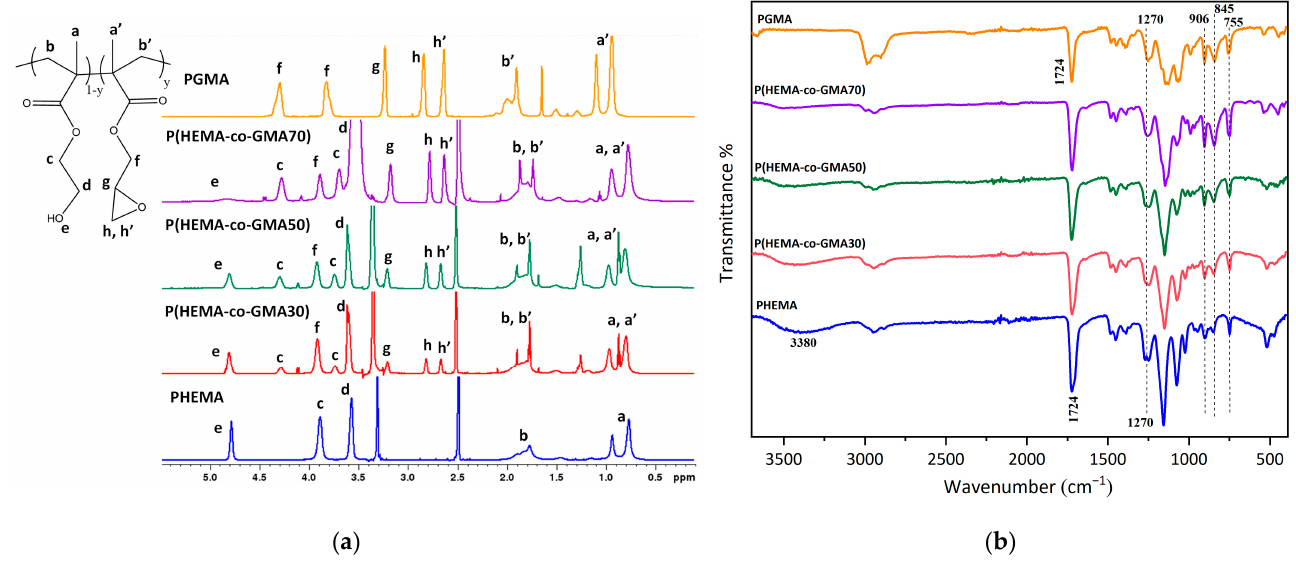
Figure 3. ( a ) 1 H NMR spectra of the P(HEMA-co-GMAy) copolymers in d 6 -DMSO. The spectra of the homopolymers PHEMA (in d 6 -DMSO) and PGMA (in CDCl 3 ), are also presented.; ( b ) ATR-FTIR spectra of the P(HEMA-co-GMAy) copolymers. The spectra of the homopolymers PHEMA and PGMA, are also presented.